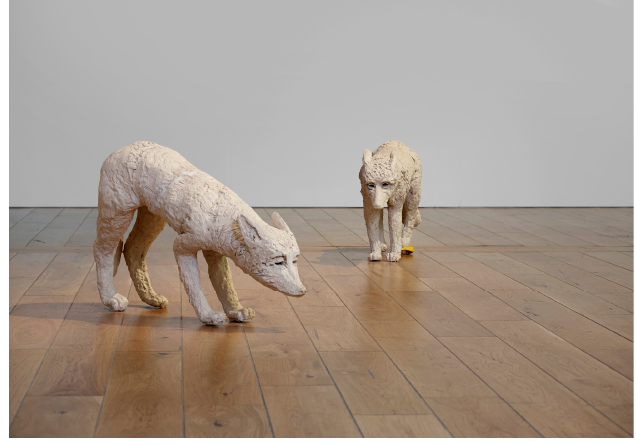
Figure 9. Foxes (2022), Fieldnotes , HOME, Manchester. Ceramic, various sizes. Photograph by Michael Pollard.